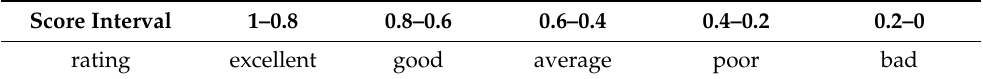
Table 3. Expert scoring standard.